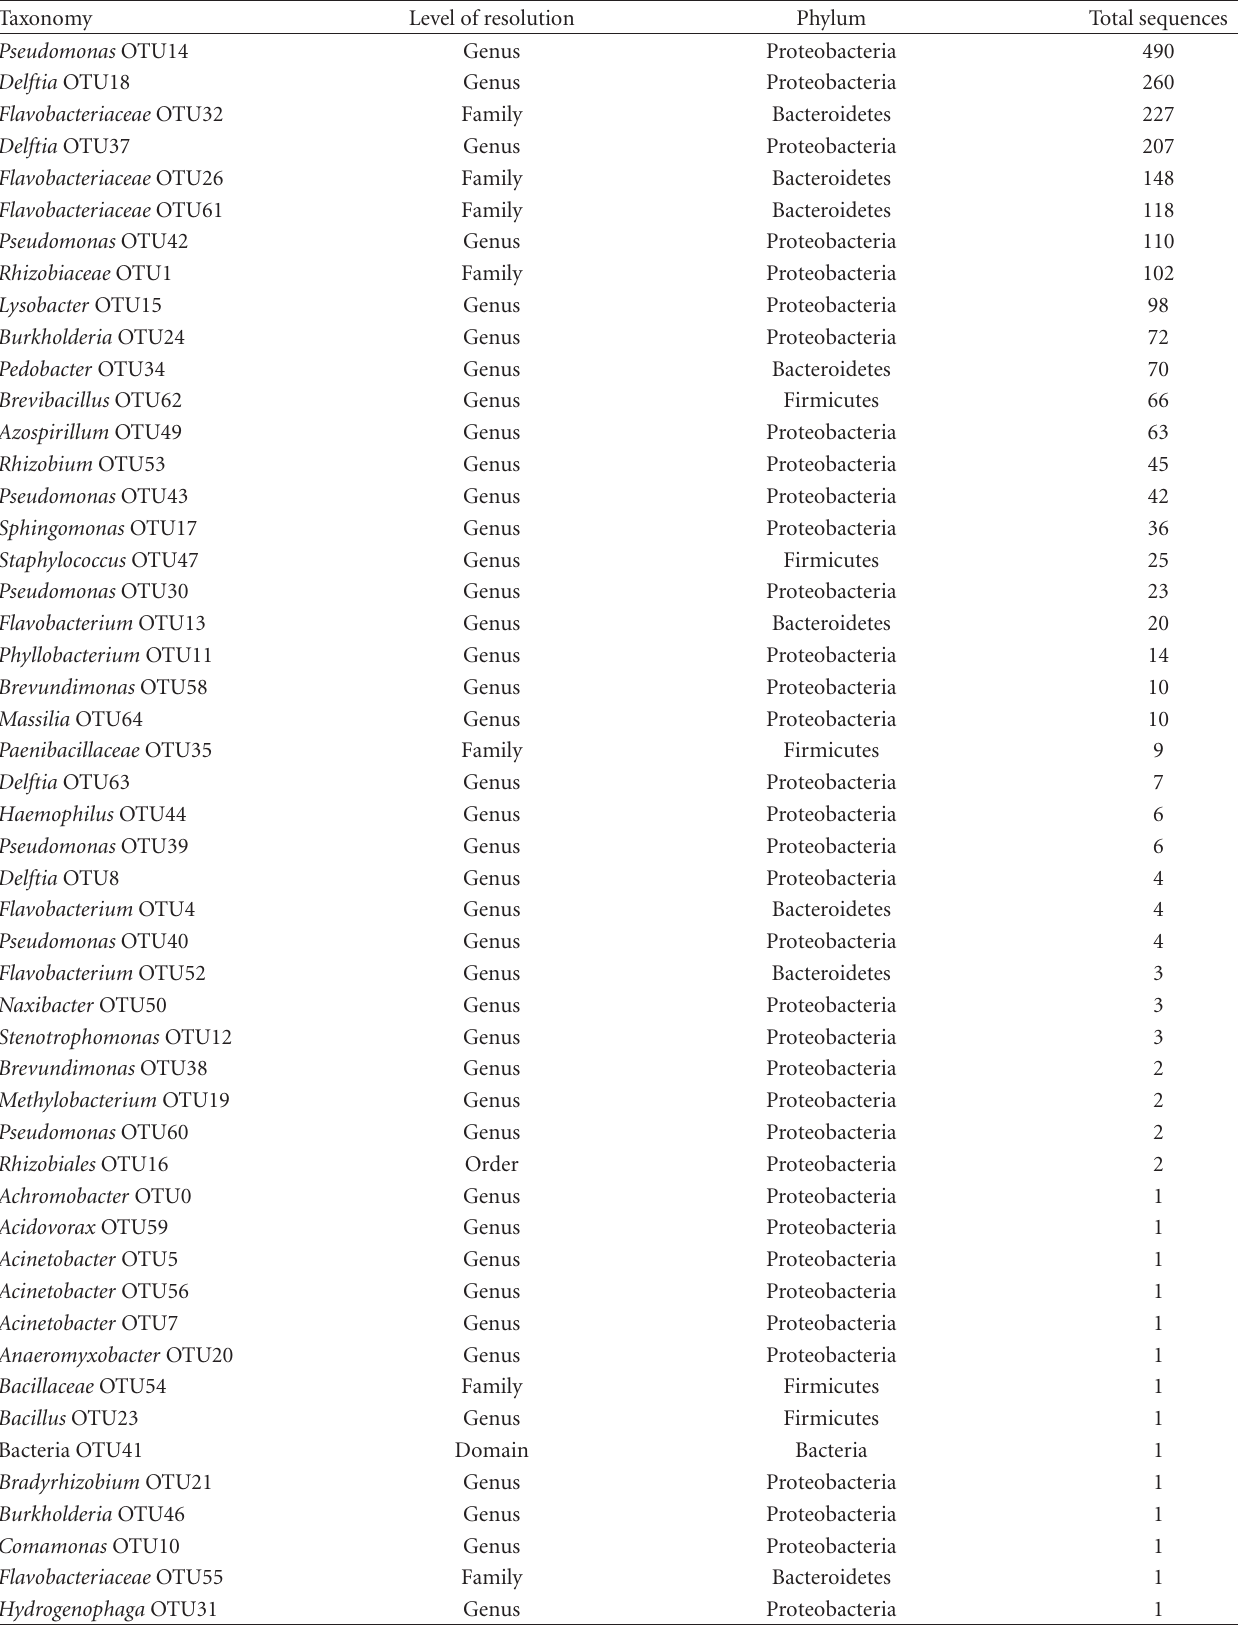
Table 3: Taxonomic classification of all